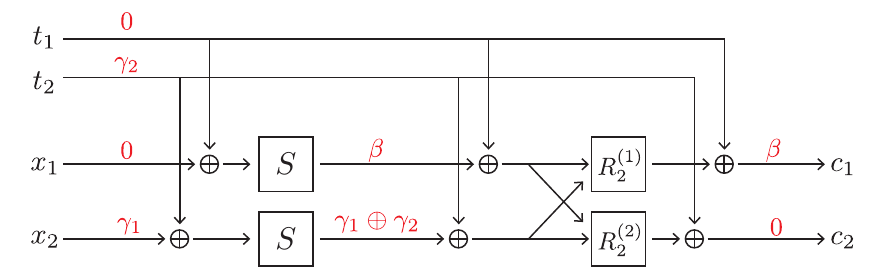
Figure 9: Propagation of masks in a simple two round tweakable block cipher with two